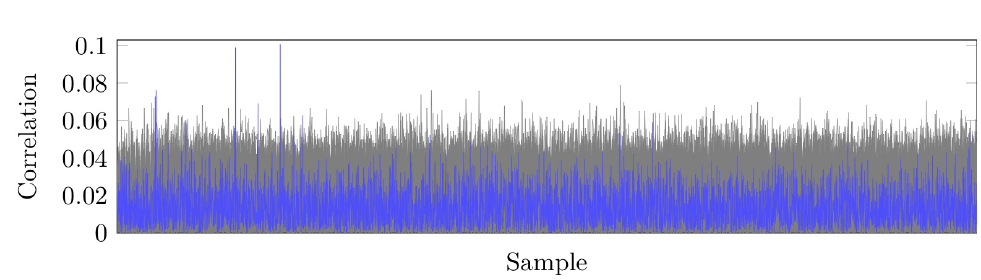
Figure 4: DCA correlation traces on the NSC variant for the good key guess (in blue) and for 256 (out of 2 16 − 1) incorrect key guesses (in